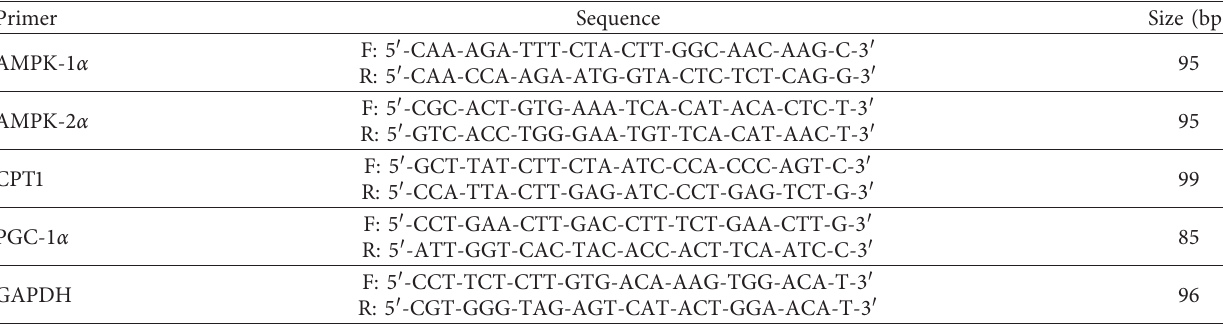
Table 1: Primer sequences used in this